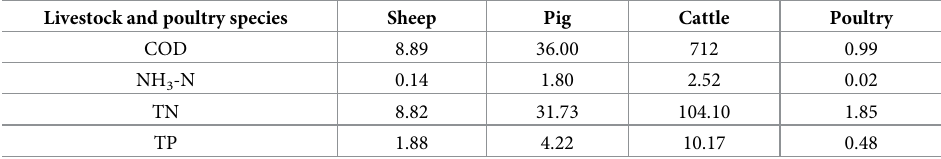
Table 3. Discharge coefficients for different livestock and poultry (kg head -1 ).